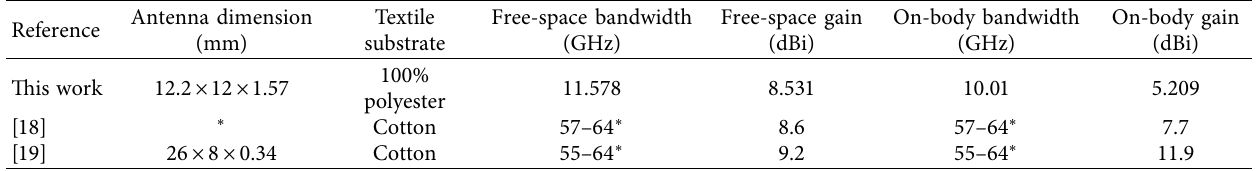
Table 11: Performance comparison with previous